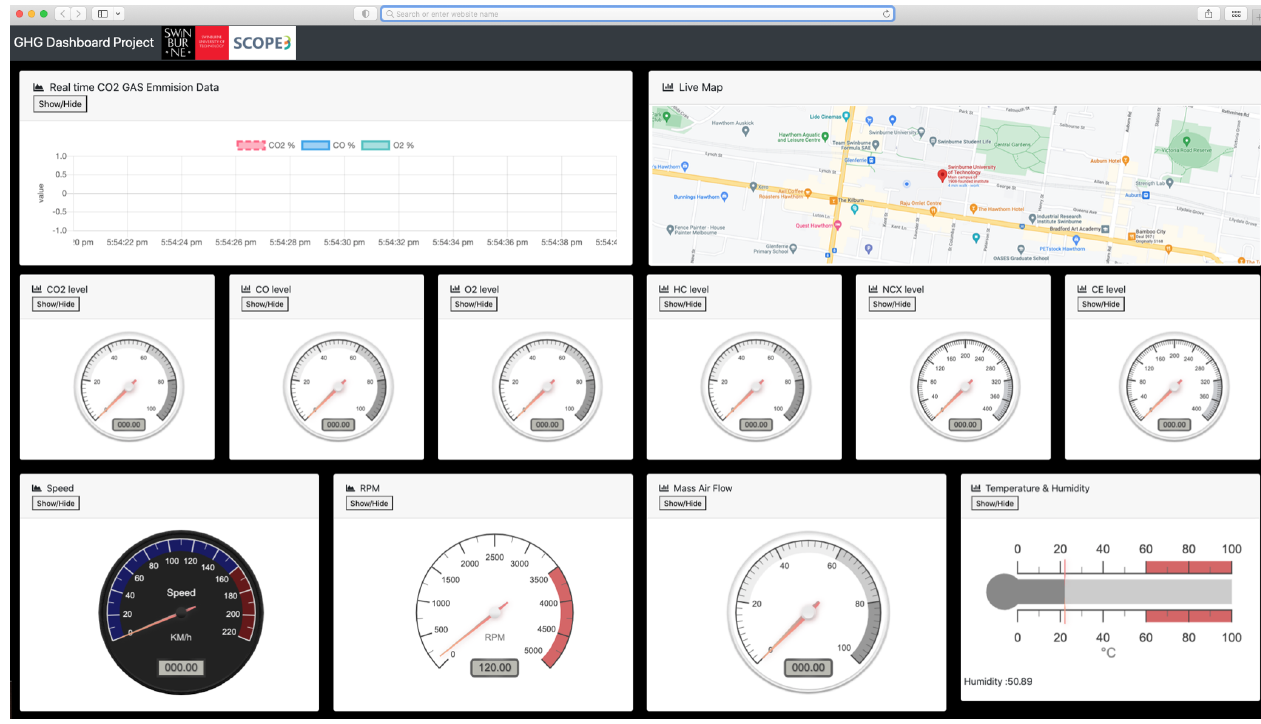
Figure 4. ParcEMon online dashboard.